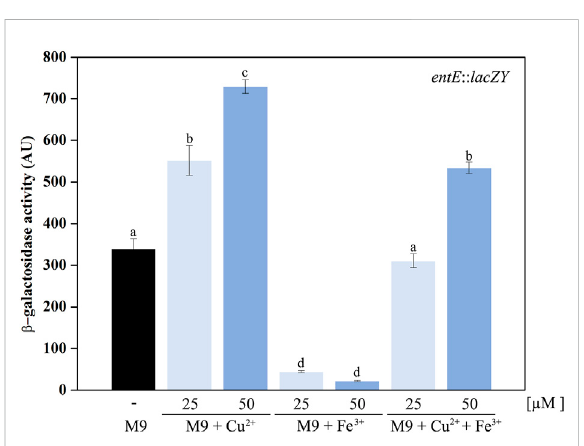
FIGURE 5 Induction of enterobactin transcriptional expression by copper. A strain with a chromosomal entE::lacZY transcriptional fusion was used as an indicator of enterobactin transcriptional expression. Data shows the control condition withoutCuSO 4 or FeCl 3 addition (black bar) and the effect of supplementing media with 25 and 50 µM CuSO 4 , 25 and 50 µM FeCl 3 and simultaneous supplementation with both copper and iron. entE expression was determined by means of a β -Galactosidase assay describedinthematerialandmethodssection.Valuesaremeans± SD for three independent experiments. Statistically signi fi cant differences between any two conditions compared are indicated withdifferentletters( p < 0.05).Samelettersindicatenostatistically signi fi cant